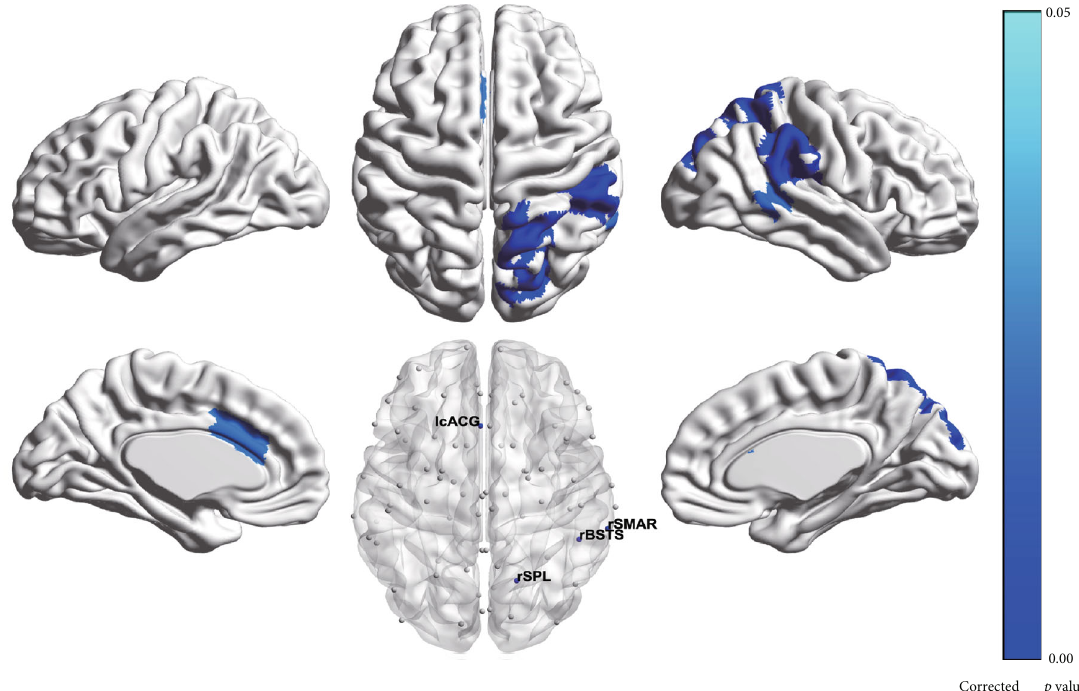
Figure 3: Di ff erences in nodal topological properties of brain structural networks between normal controls and patients. (a) Regions with decreased nodal strength in patients. (b) Regions with decreased nodal e ffi ciency in patients. (c) Regions with decreased local clustering coe ffi cient in patients. The di ff erences survived critical FWE